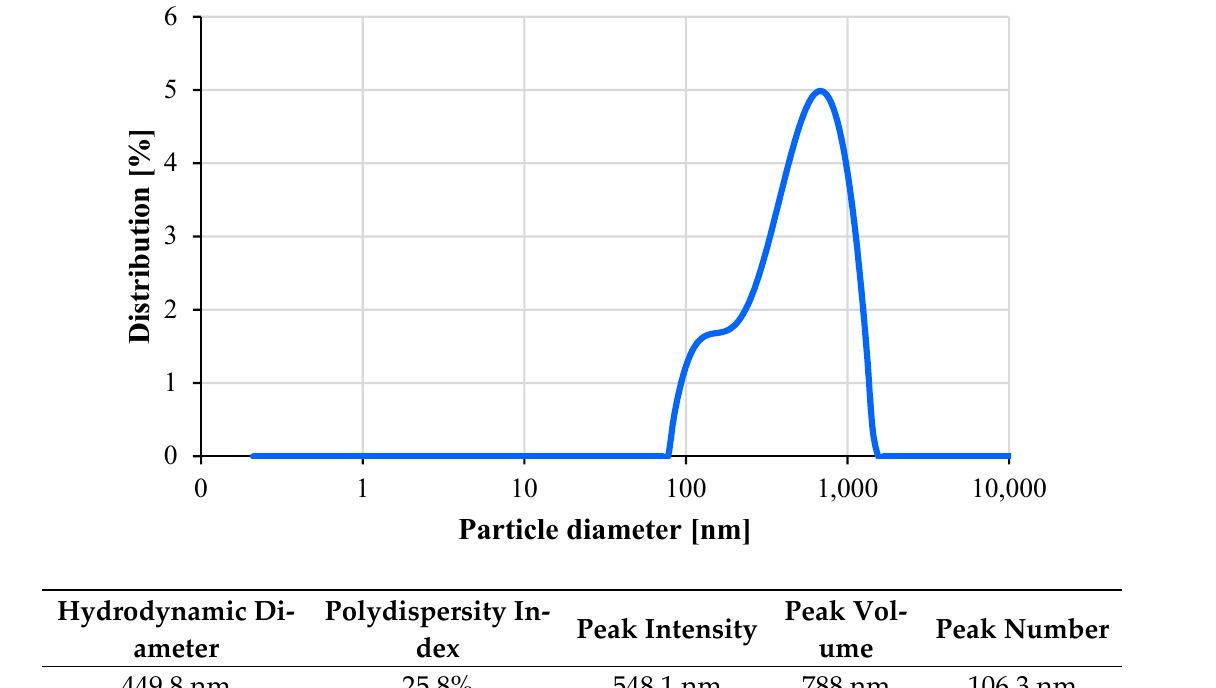
Figure 5. Particle size distributions for GNPs nanofluid at 25 °C. The dispersion and stabilization of the GNPs-nanofluid were imaged using an SEM. It can be seen in Figure 6 that the GNPs lack aggregation and are well dispersed. A highly wrinkled structure is also evident, which can be attributed to the functionalization via a strongly acidic medium. Additionally, Figure 6 shows the elements reported by the EDX measurements of the GNPs; carbon (C), oxygen (O), silicon (Si), and sulfur (S), with the corresponding atomic content being 95.36%, 4.57%, 0.03%, and 0.05%, respectively. These values confirm the excellent quality of the tested samples and agree with the results found in the literature [36].